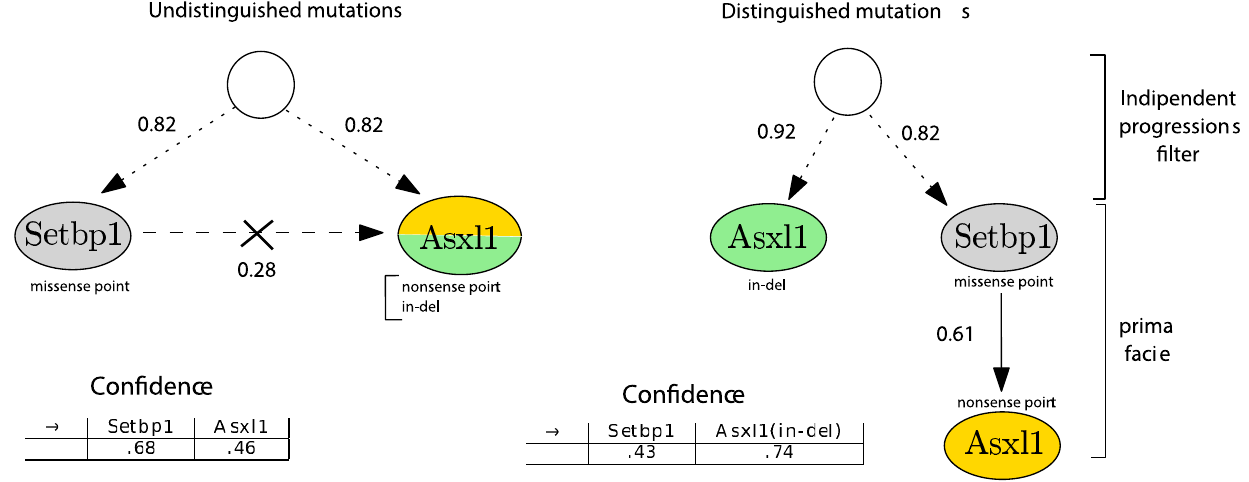
Figure 8. Validating the S ETBP 1 - ASXL1 relation in atypical Chronic Myeloid Leukemia. Progression models where ASXL1 indel and non- sense point are merged (left) and separate (right) suggest that a missense point mutation hitting SETBP1 can cause a non-sense point mutation in ASXL1, that the observed ASXL1 mutations might be independent and that indel ASXL1 is an early event with high confidence. doi:10.1371/journal.pone.0108358.g008 PLOS ONE |